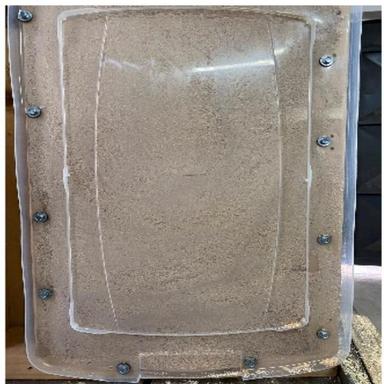
Material applied to a test specimen.